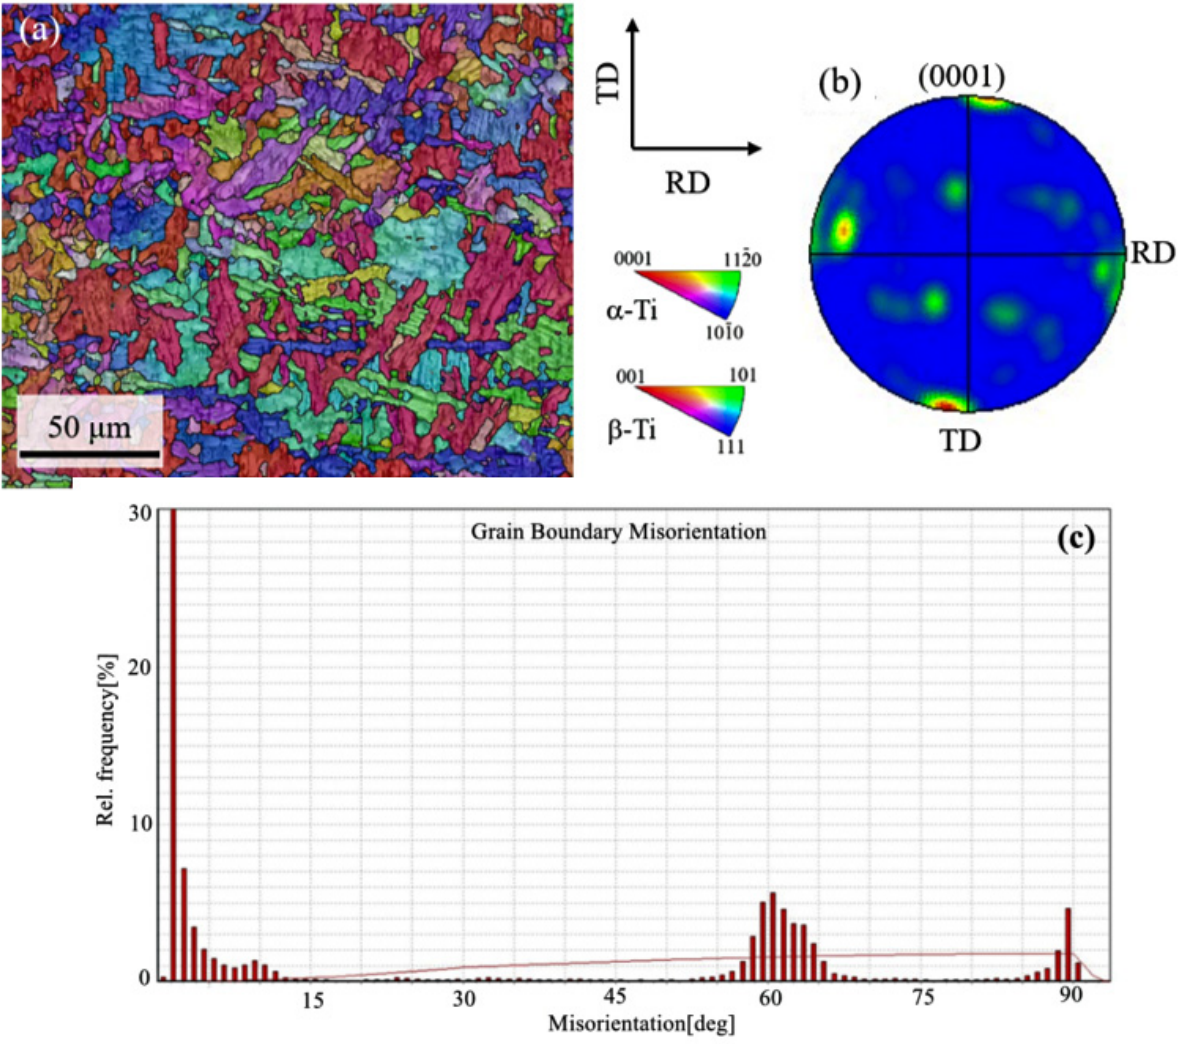
Figure 2. ( a ) Inverse pole figure along the transverse direction; ( b ) Pole figure and ( c ) grain boundary misorientation distribution of the initial